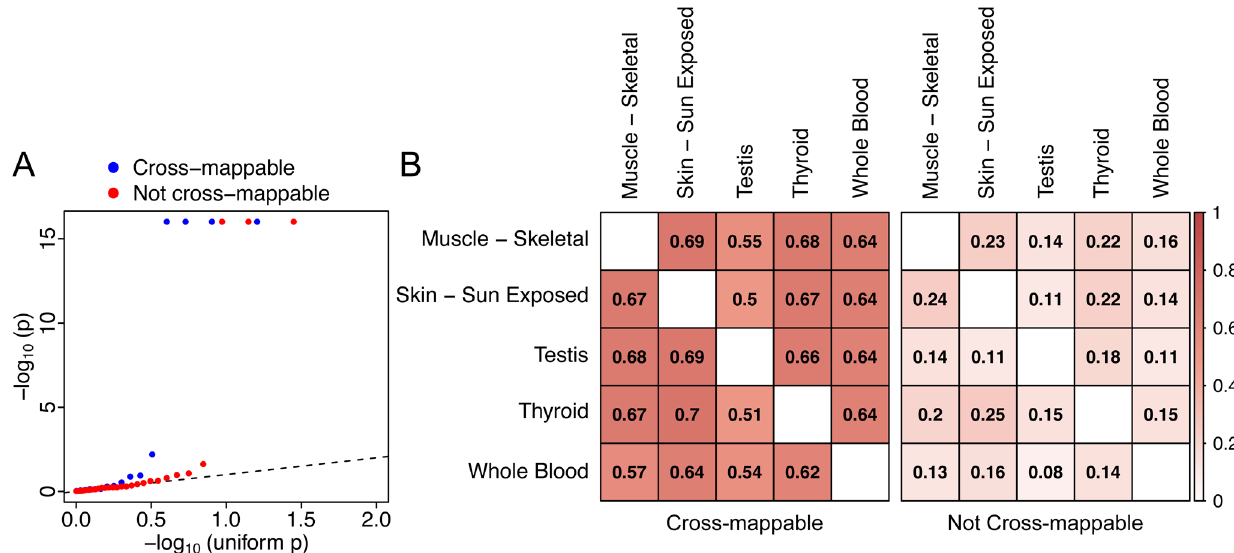
Figure 3. Trans-eQTL replication. ( A ) Q-Q plot, replication p-values from DGN for variant-gene pairs discovered in GTEx Whole Blood, grouped by cross-mappability. ( B ) The fraction of significant eQTLs in each GTEx tissue (row) replicated in another tissue (column) at FDR ≤ 0.05, for cross-mappable eQTLs (left) and not cross-mappable eQTLs (right).